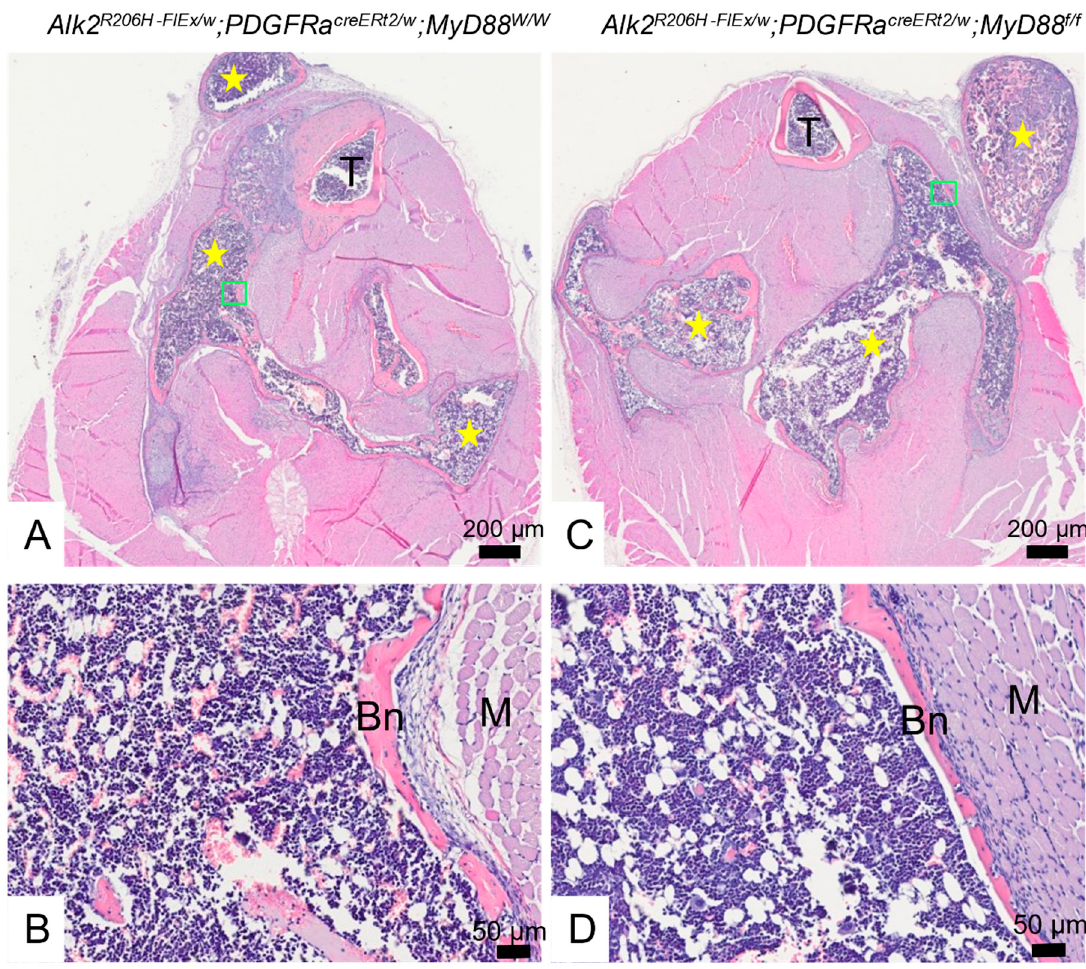
Figure 3. Gross histological examination of EHO in injured hindlimbs of Acvr1 R206H_FlEx ;MyD88 w/w ( A , B ) and Acvr1 R206H_FlEx ;MyD88 Pdgfr α− / − ( C , D ) mice. The tissue and cellular composition of injured lower hindlimbs was examined in H&E-stained transverse sections of decalcified paraffin embedded specimens collected 21 dpi. Legs from both genotypes consistently contained large amounts of mature intramuscular heterotopic bone (yellow stars in ( A , C )) filled with bone marrow with an unremarkable composition of hematopoietic cells, adipocytes, and erythrocytes ( B . D ) that appeared similar to that in host tibia (T). The green boxes in ( A , C ) mark the approximate locations of the images in ( B , D ). Bn = bone, M = muscle, and T = tibia.